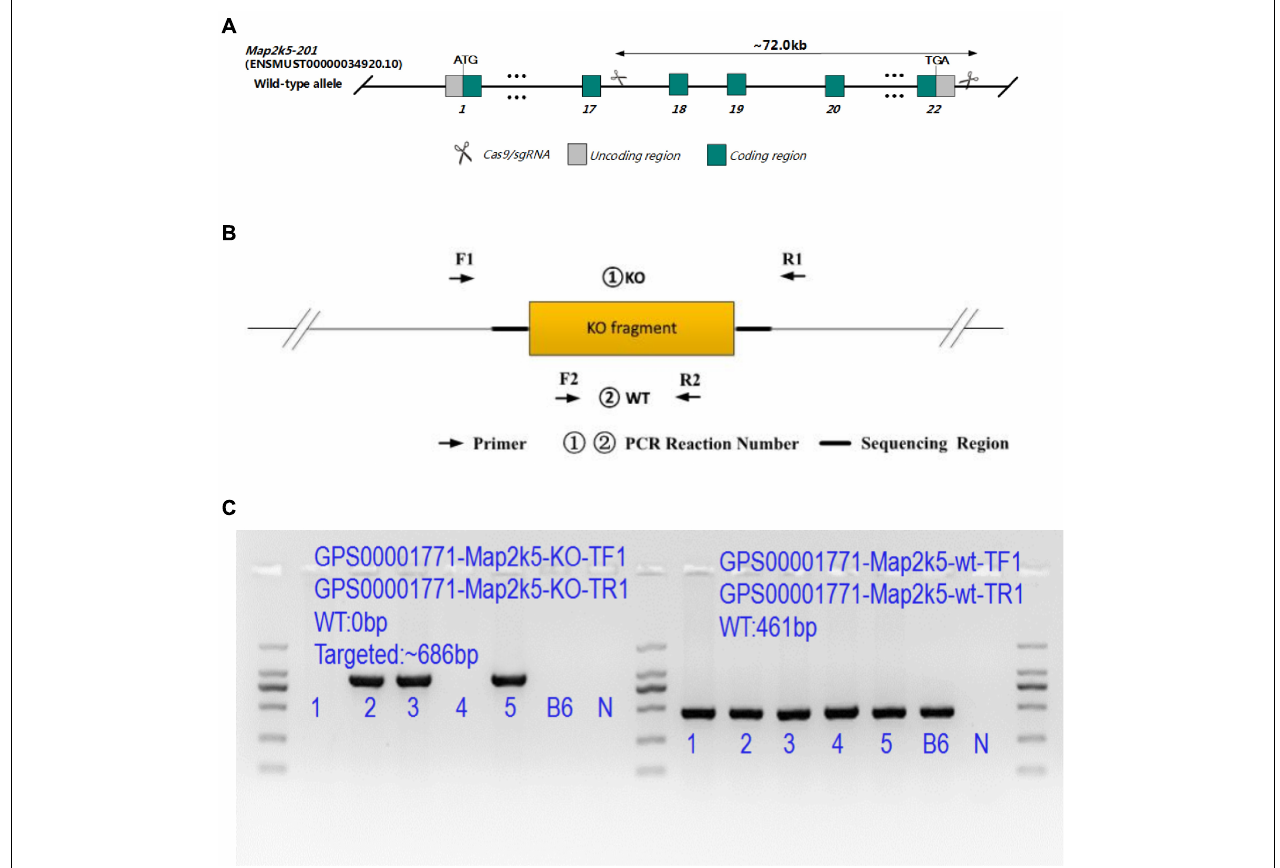
FIGURE 1 | (A) Targeting strategy of Map2k5-targeted allele. Green boxes represent coding regions, gray boxes represent noncoding exon regions, and scissors represent the targeted area of Map2k5 between exons 18 and 22. (B) Primers designed for genotype identification of Map2k5 + / − heterozygous and wild-type (WT) mice. (C) PCR results of some Map2k5 em41 Cd71454